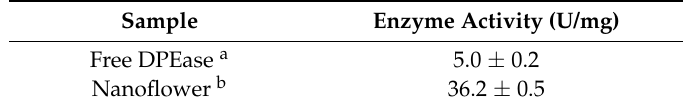
Table 2. Comparison of enzyme activity of nanoflower and free DPEase.